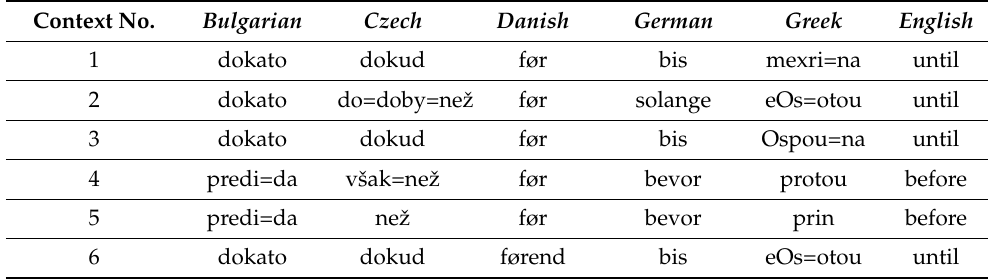
Table 3. Extract from the connective cross